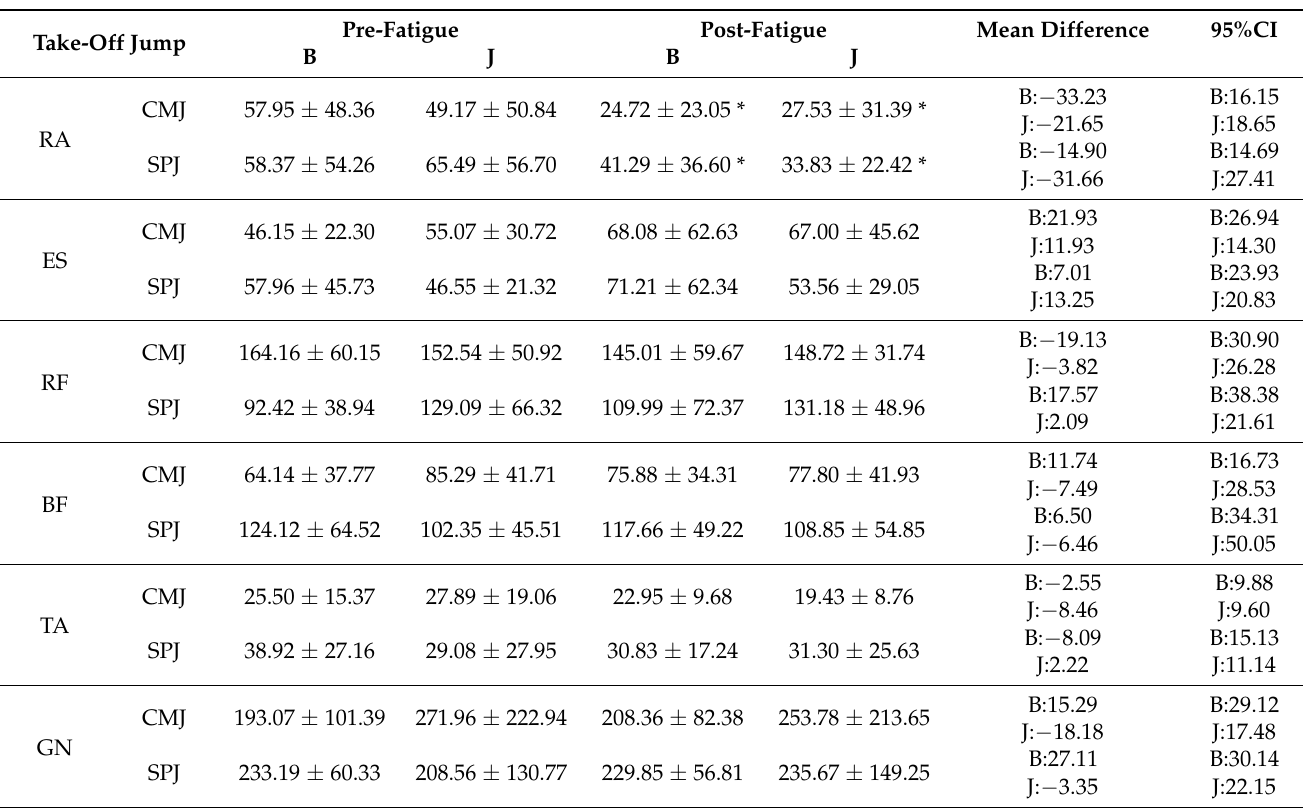
Table 4. Muscle activation during take-off